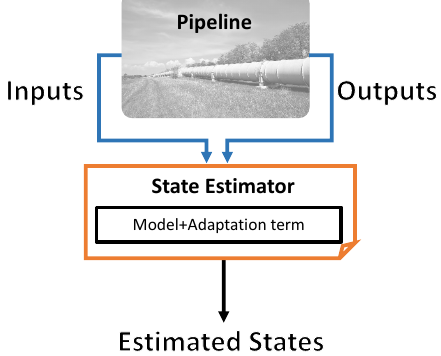
Figure 1. Architecture of a computational pipeline monitoring (CPM) system based on a state